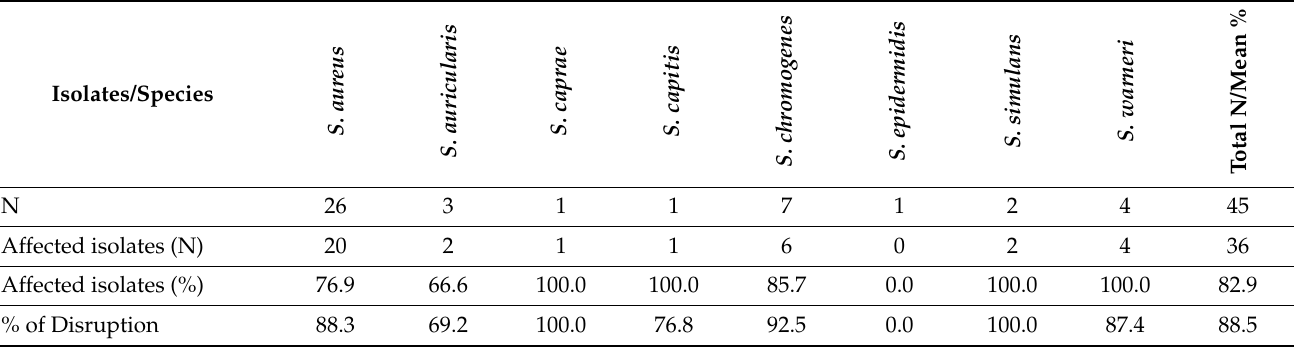
Table 4. Propolis effect on established biofilms: number and respective percentage of isolates and mean percentage of biofilm